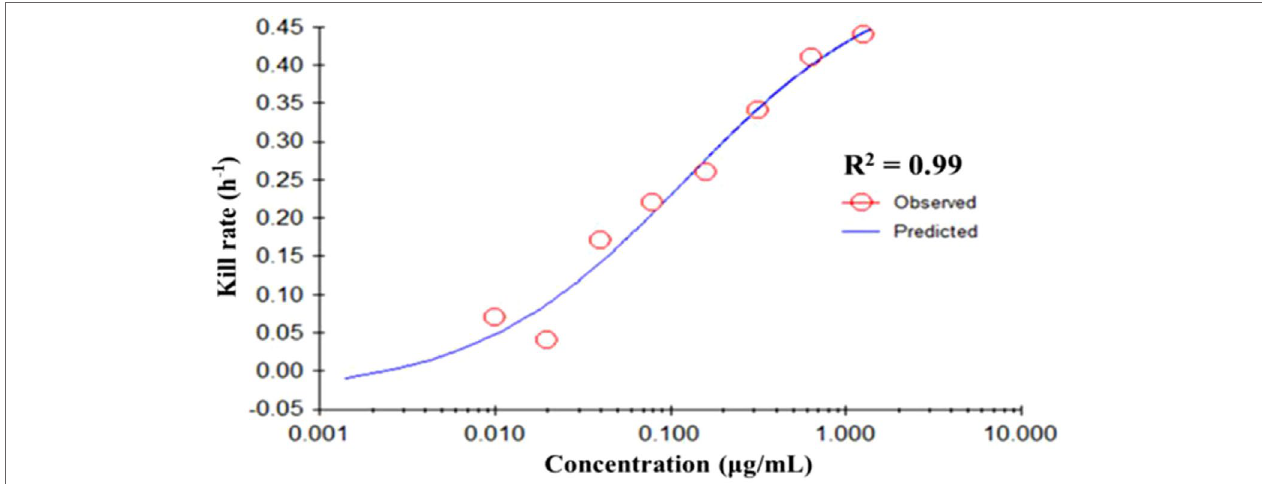
FIGURE 3 | The best-fit curve obtained from the E max model of M. gallisepticum exposed to tilmicosin between 0 and 48 h. R 2 is the correlation coefficient. E max , sigmoid maximum